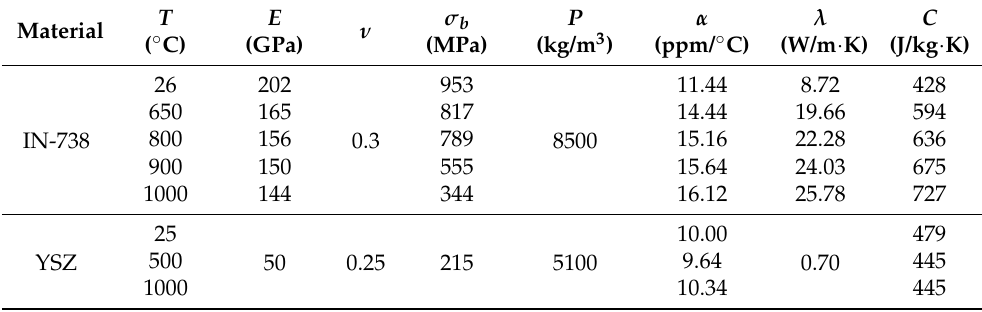
Table 4. Physical and mechanical property parameters of the matrix and the coating.